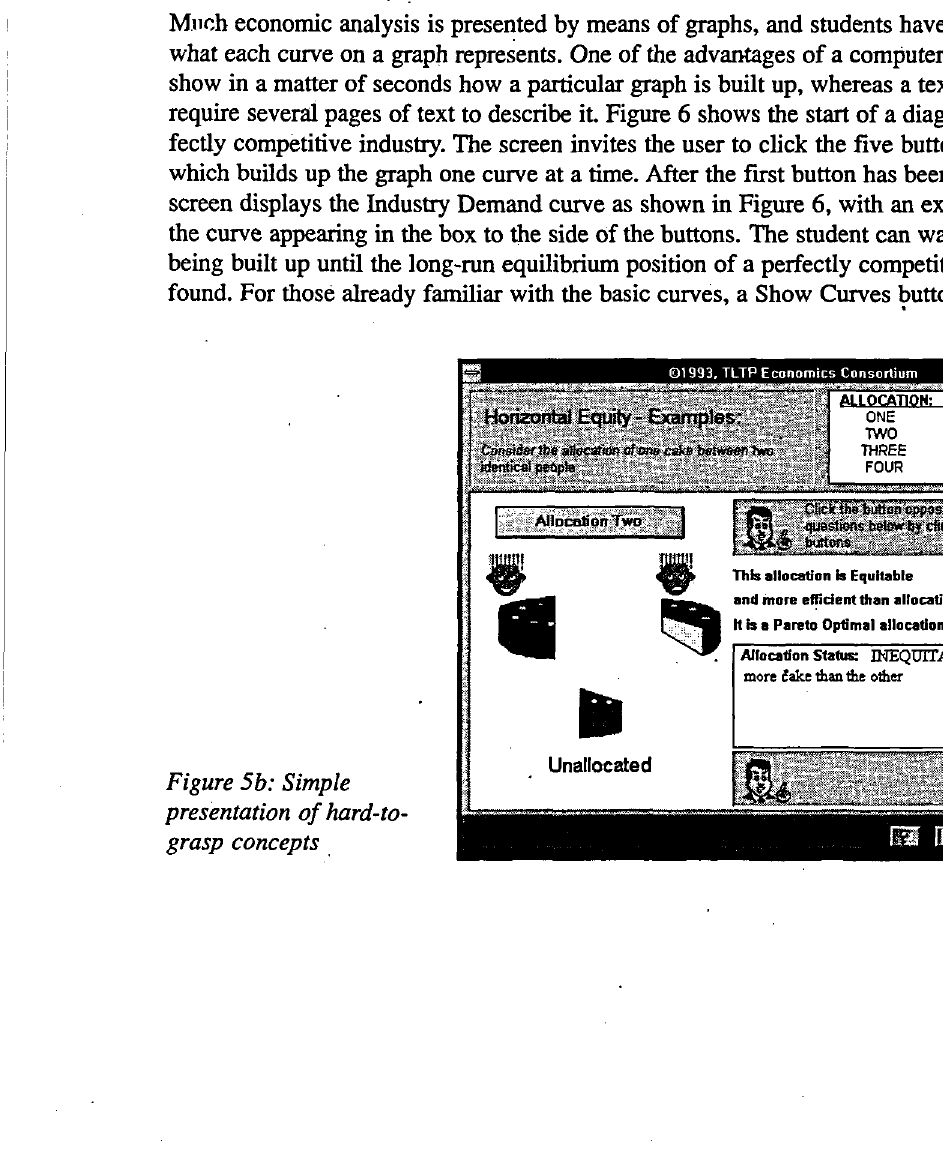
Figure 5b: Simple presentation of hard-to- grasp